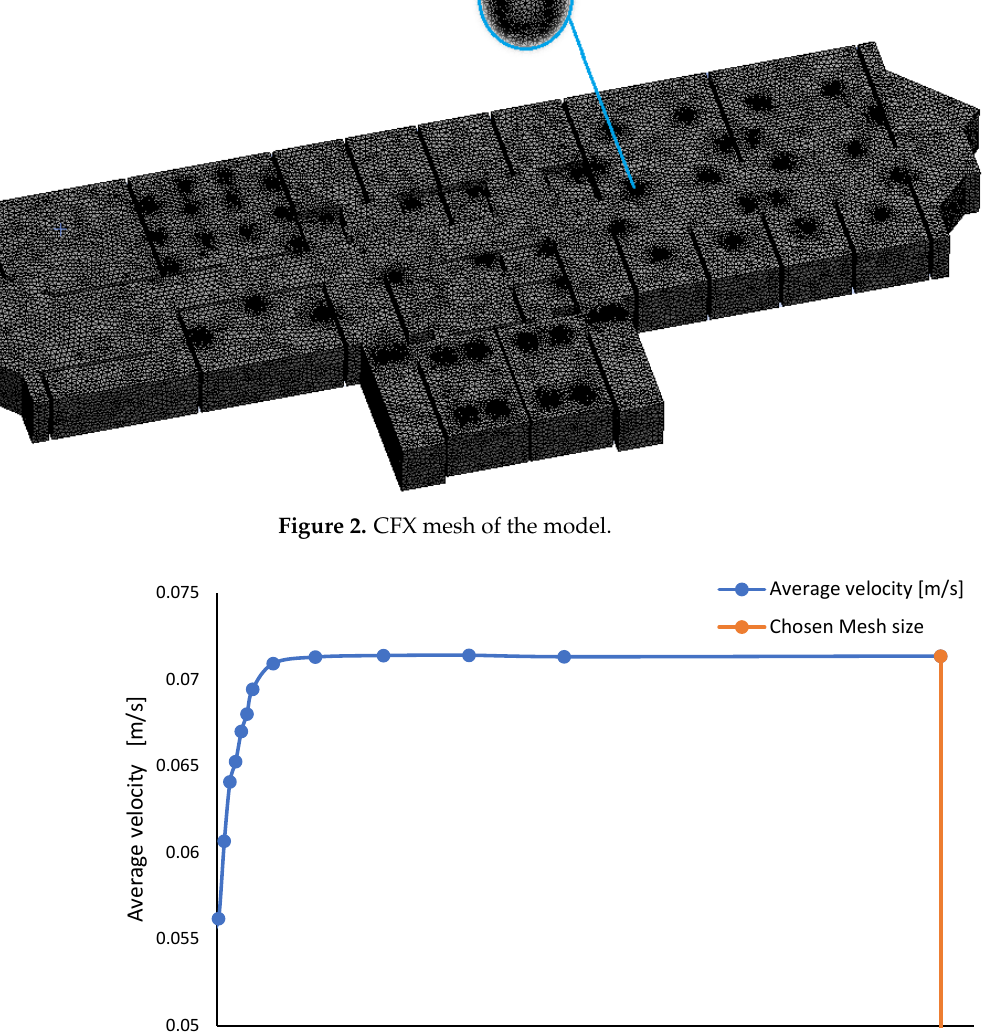
Figure 3. Mesh sensitivity analyses with respect to the average velocity at 1.7 m offset.